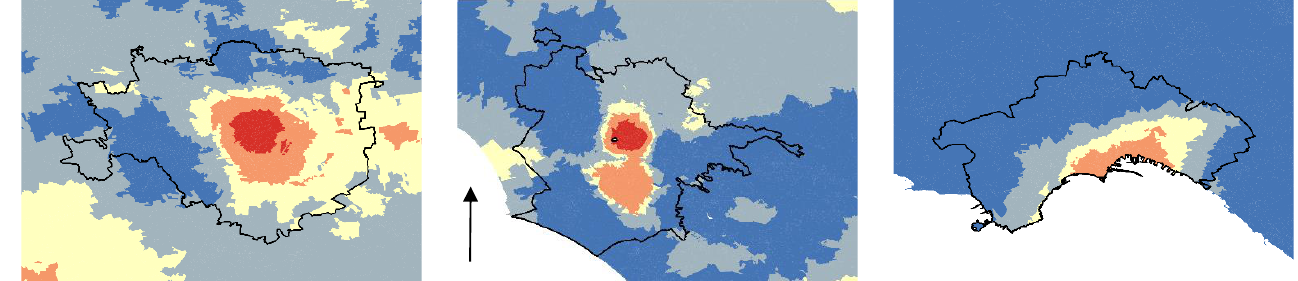
Figure 4. Three examples of the spatial distribution of local intercepts of a Geographically Weighted Regression with the polarization index as the dependent variable and the enumeration district area as the predictor ( left : Milan; middle : Rome; and right : Naples). Blue values indicate a zero local intercept. Red values indicate a local intercept higher than 1. The highest intercept values (red) correspond with downtown settlements in all examples (arrow indicates the North).